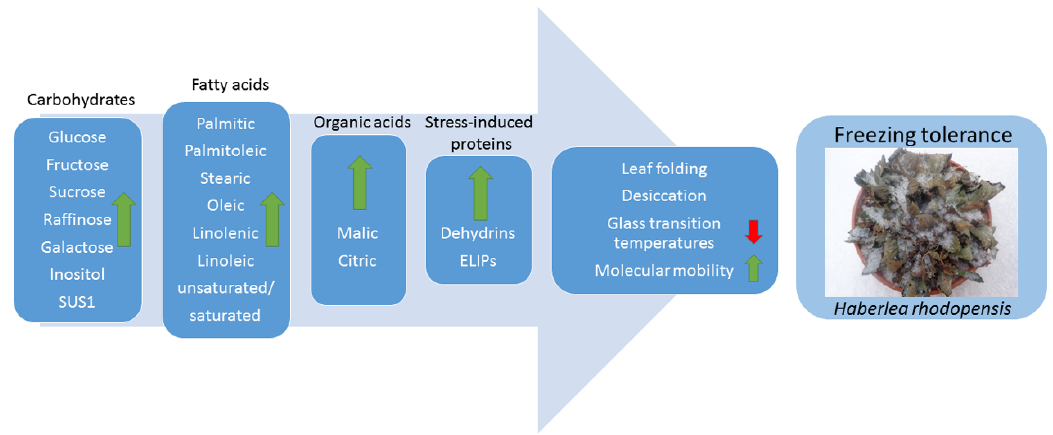
Figure 11. Schematic representation of the protective strategies used by H. rhodopensis to achieve freezing tolerance.